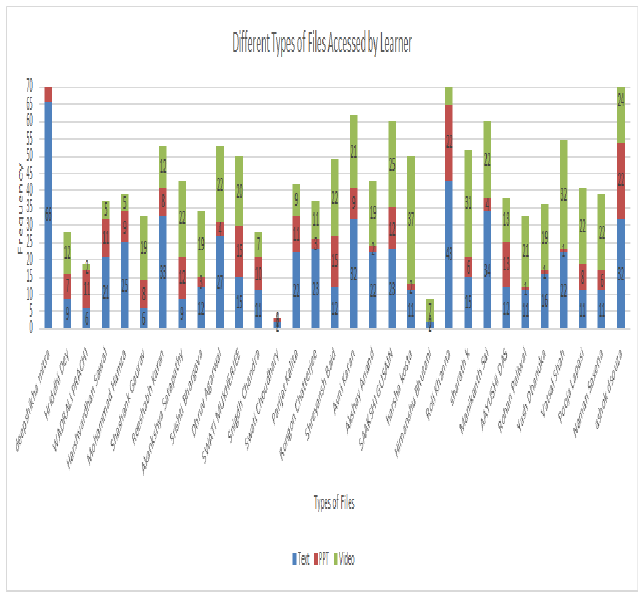
Figure 3. Number of Times Learners Accessed Specific Type